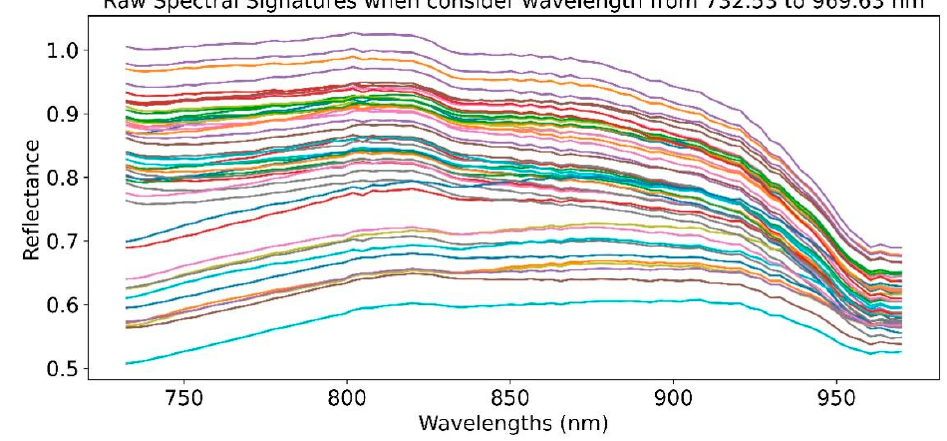
Figure 5. Raw spectral signatures when considering wavelength from 700 nm to 1000 nm.